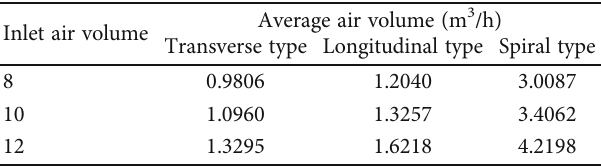
Figure 12: Air volume distribution fi gures: (a) when the ventilation rate is 12m3/h, the outlet air volume of each pipeline in the transverse type; (b) the pipeline of the spiral type corresponds to the outlet air volume from the abdomen, lower waist, middle waist, back, and chest of the human body. Table 3: Datasheet for average air volume in the